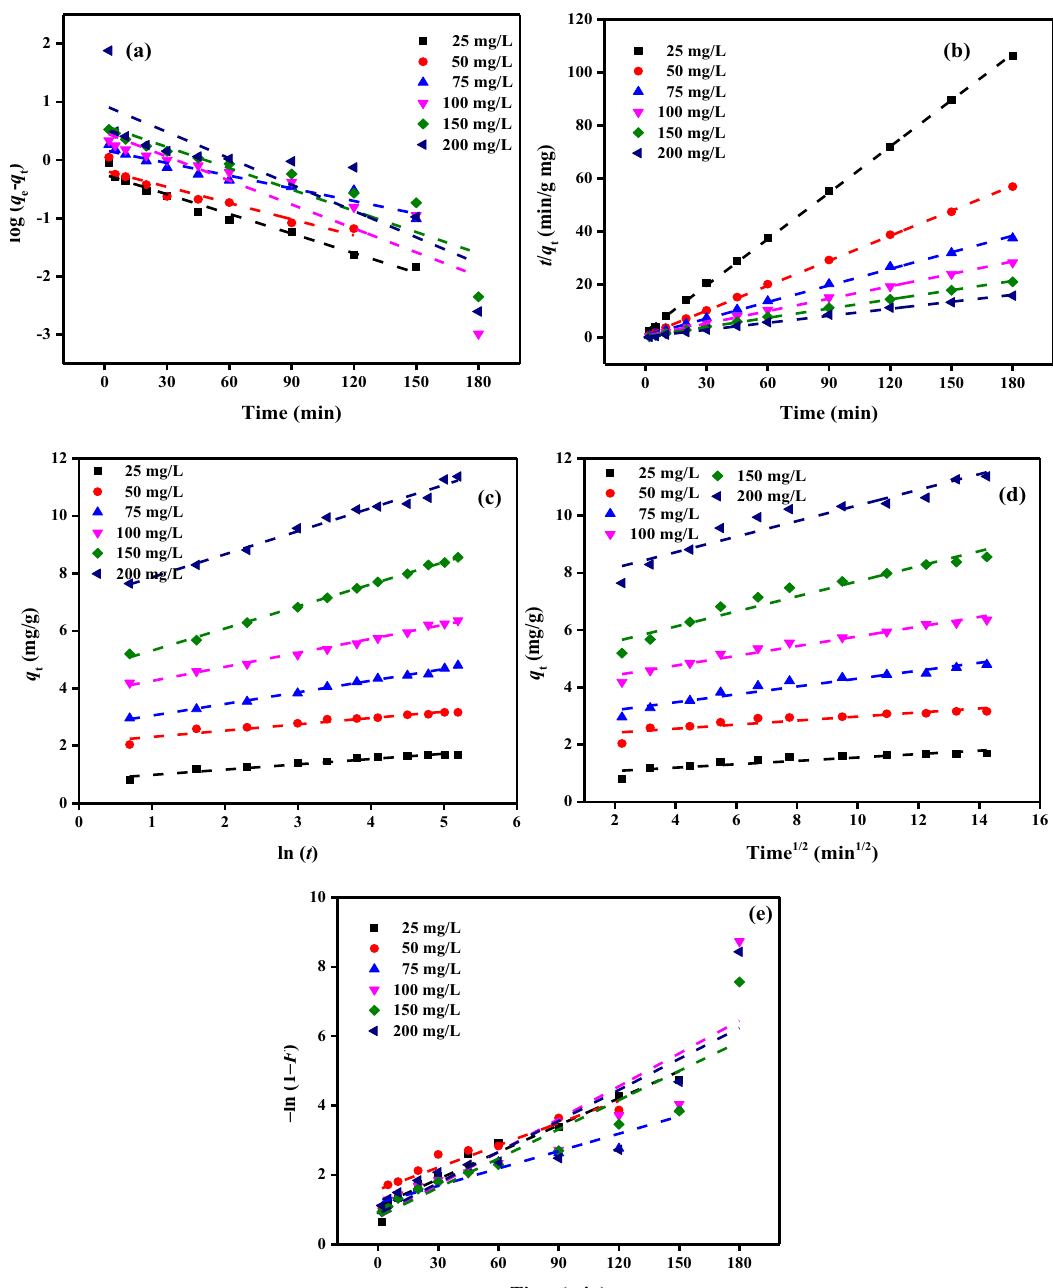
Figure 12. ( a ) PFOM, ( b ) PSOM, ( c ) EM, ( d ) IPDM, ( e ) FDM of absorption of DB86 dye [ C 0 (25–200 mg/L) by CAH dose (9.0 g L −1 ), temp. (25 ± 2